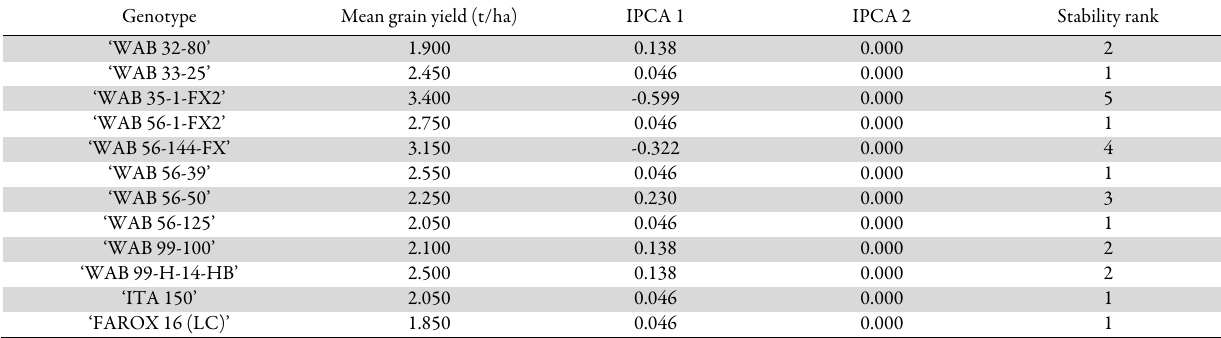
Table 4. Grain yield performance and stability of the 12 rice genotypes for the two years